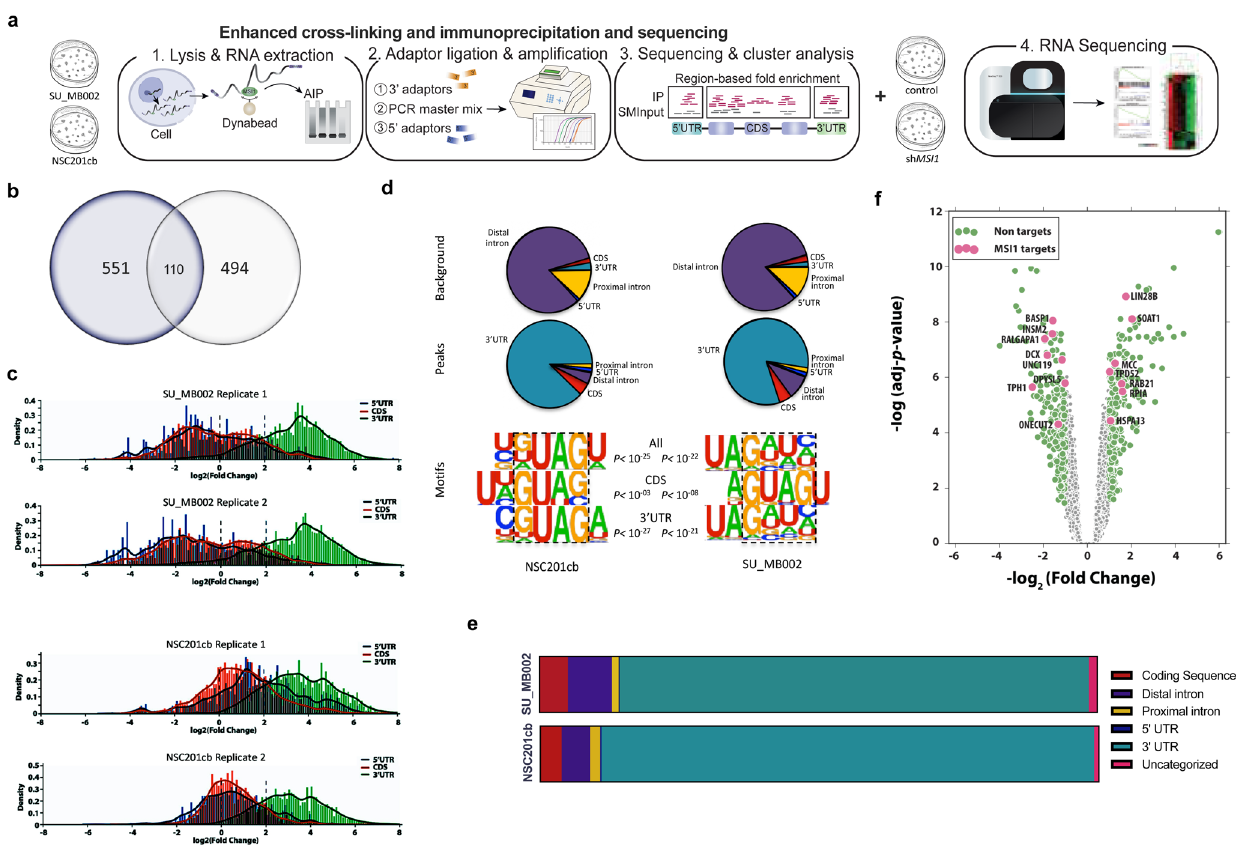
Fig.2|eCLIPanalysisrevealskeyMSI1boundtranscriptsinvolvedinprocesses associated with chromatin remodeling, transcription and translation. a Schematic of experimental plan to identify MSI1 binding in SU_MB002 and NSC201cbandexaminationofchangestosteadystatetranscriptomewithRNA-seq, b Venn diagram showing moderate overlap of binding genes between SU_MB002 and NSC201cb (>3logFC), c eCLIP peak calling identi fi es 3 ′ UTR (green peaks) as